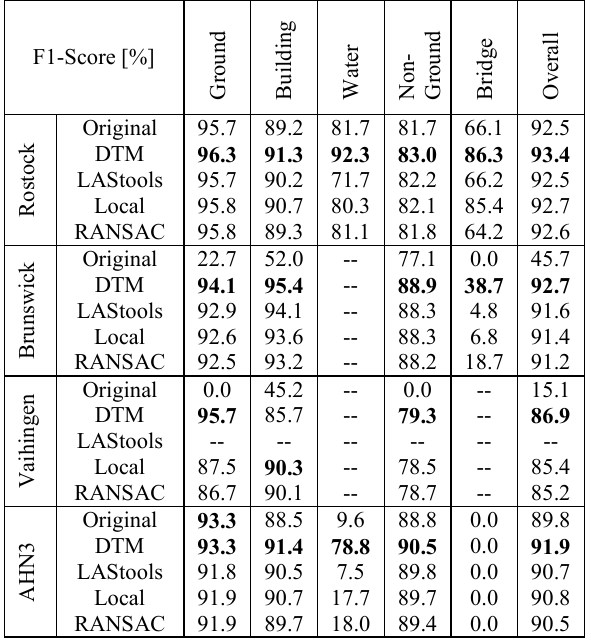
Table 1. F1-Scores from the accumulated prediction of ten networks. Best results for each test set are marked bold. Only the predictions of Vaihingen achieve lower overall F1- Scores of about 85% as shown in Table 1, which are mostly due to some issues at the border of the point clouds (see Figure 5). Results of the different test areas are shown in greater detail in Table 1 and Figure 5. Even though the overall F1-Scores are similar in all test sets, the class specific F1-Scores vary notably. Having class weighting been used during training, classes with more available points such as ground , building and non-ground still achieve higher and more stable results in all test sets than the smaller classes water and bridge (see Figure 5, Table 1). As shown in Table 1, the ground class appears to be the most stable, but is also the most common class in all test sets. The best class F1-Scores for ground in each test set only differ by 3% with AHN3 achieving the lowest score of 93.3%. Similarly, building is quite stable and the best F1-Scores in each test set only vary between 90.3% and 95.4%. The later result is interesting as building was predicted better in Brunswick (95.4%) than in Rostock (91.3%). This might be due to the lack of vegetation close to most buildings in Brunswick, which consequently decreases the chance of having border issues between objects (see Figure 3, middle). Equally, one of the major drawbacks of non-ground classification originates in the limitations of our approach, which are further discussed in this section below. As a result, non-ground achieves best F1-Scores varying from 79.3% to 90.5% between test sets and roughly 2% difference within a test region. Water points hardly exist in ALS point clouds due to the reflection of the beam if the plane is not in nadir view to the respective water source. In most ALS point clouds, water points are usually spatially apart from the other object points and are mostly surrounded by the no data class representing the lack of points within a raster cell in our approach. As a result, the network learns this topological characteristic and thus classifies points on the riverside as water